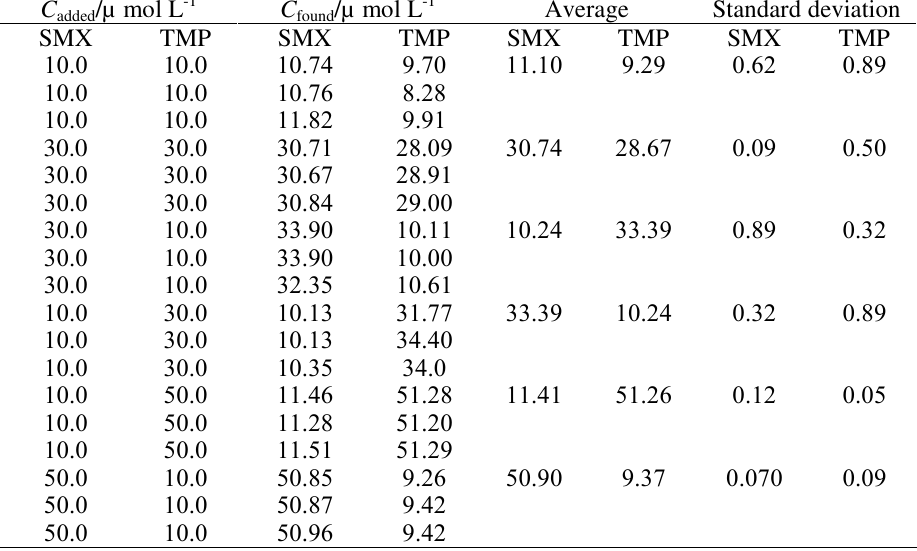
Table 2. Replicate measurements results of naphazoline and antazoline in some synthetic mixtures C /µ mol L -1 added